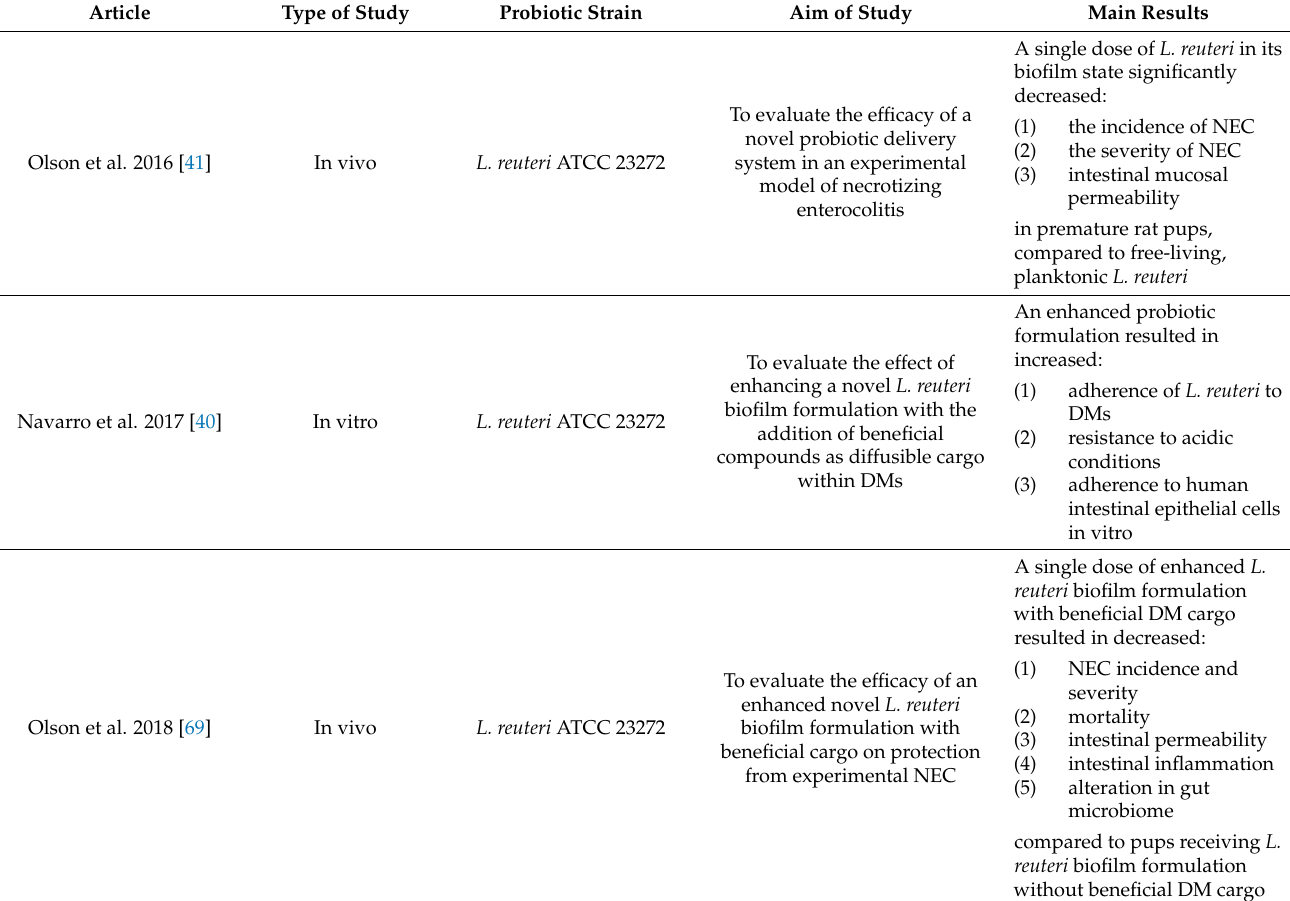
Table 1. Summary of in vitro and in vivo investigations with main